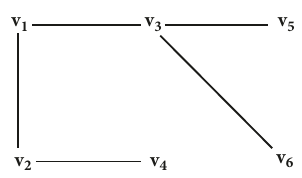
Figure 1: Communication graph with six